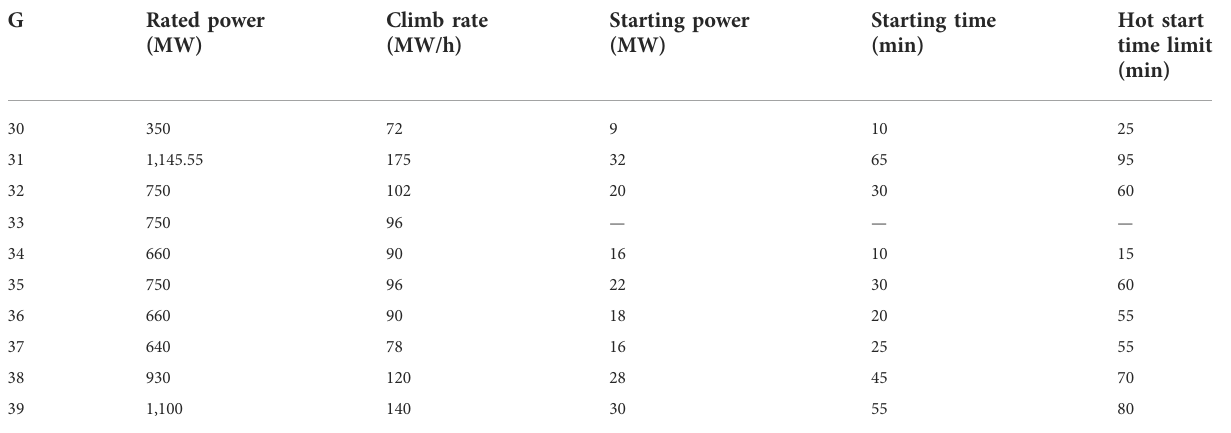
TABLE 1 Related parameters of the generators.